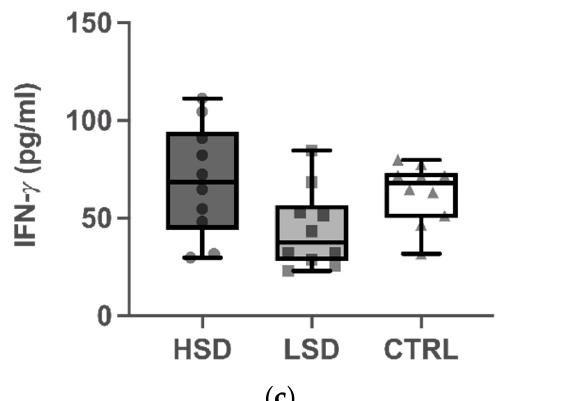
Figure 3. Effect of different concentrations of dietary sodium on the production of cytokines by splenocytes. Splenocytes were isolated from the spleens after OVA challenge and incubated in culture medium containing fetal bovine serum (FBS) and OVA for 1 to 3 days. Interleukin (IL)-4 ( a ), IL-10 ( b ), and interferon- 𝛾 (IFN- 𝛾) ( c ) were measured by sandwich ELISA. Data are expressed as box-and-whisker plots with individual data points. The boxes represent the inner quartiles value range with the median indicated as black line. The whiskers represent minimum to maximum interval. * p < 0.05 and ** p < 0.01. High-salt diet: HSD, Low-salt diet: LSD, Control diet: CTRL